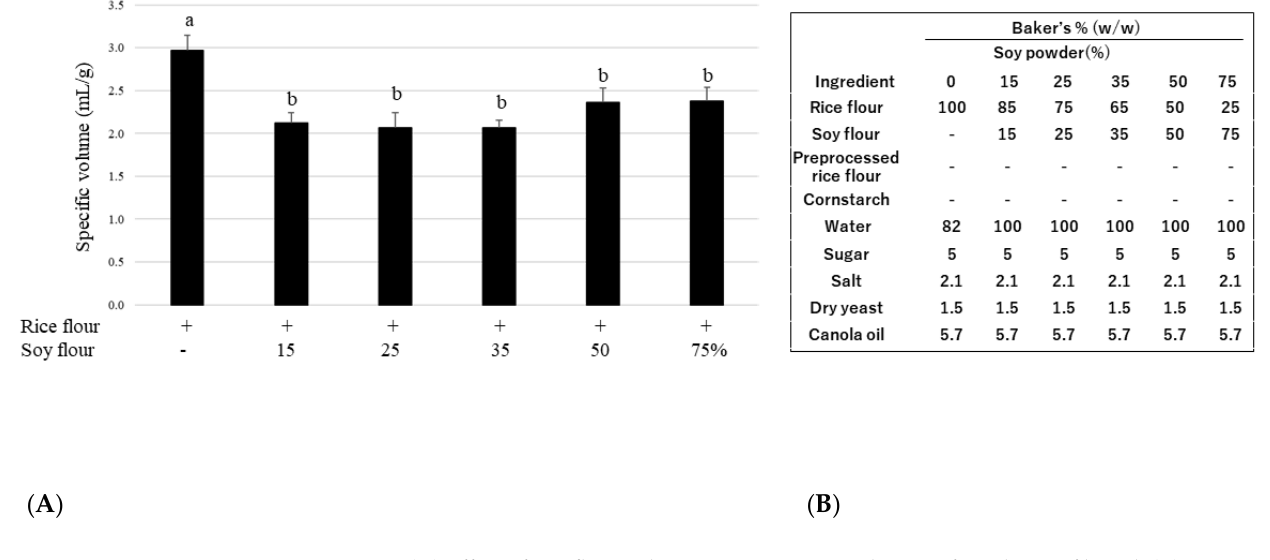
Figure 1. ( A ) Effect of soy flour substitution amount on the specific volume of bread; ( B ) Recipes for soy rice bread. Data are shown as mean ± SD. Different letters indicate p < 0.05 between groups.